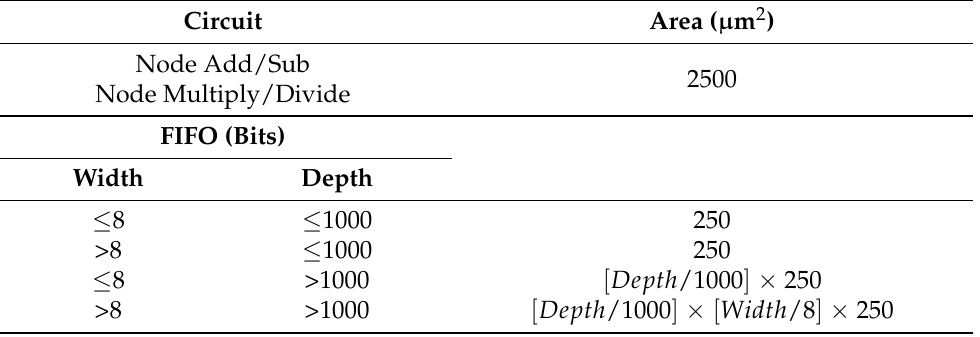
Table 4. Area Occupancy Estimations of Electronic Circuits used in